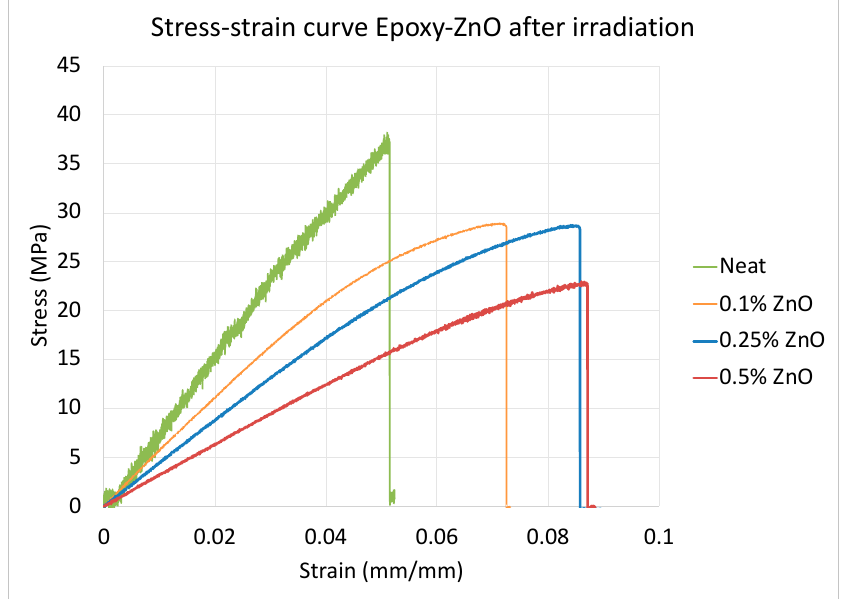
Figure 7. Stress–strain curves for epoxy-ZnO composites after irradiation.